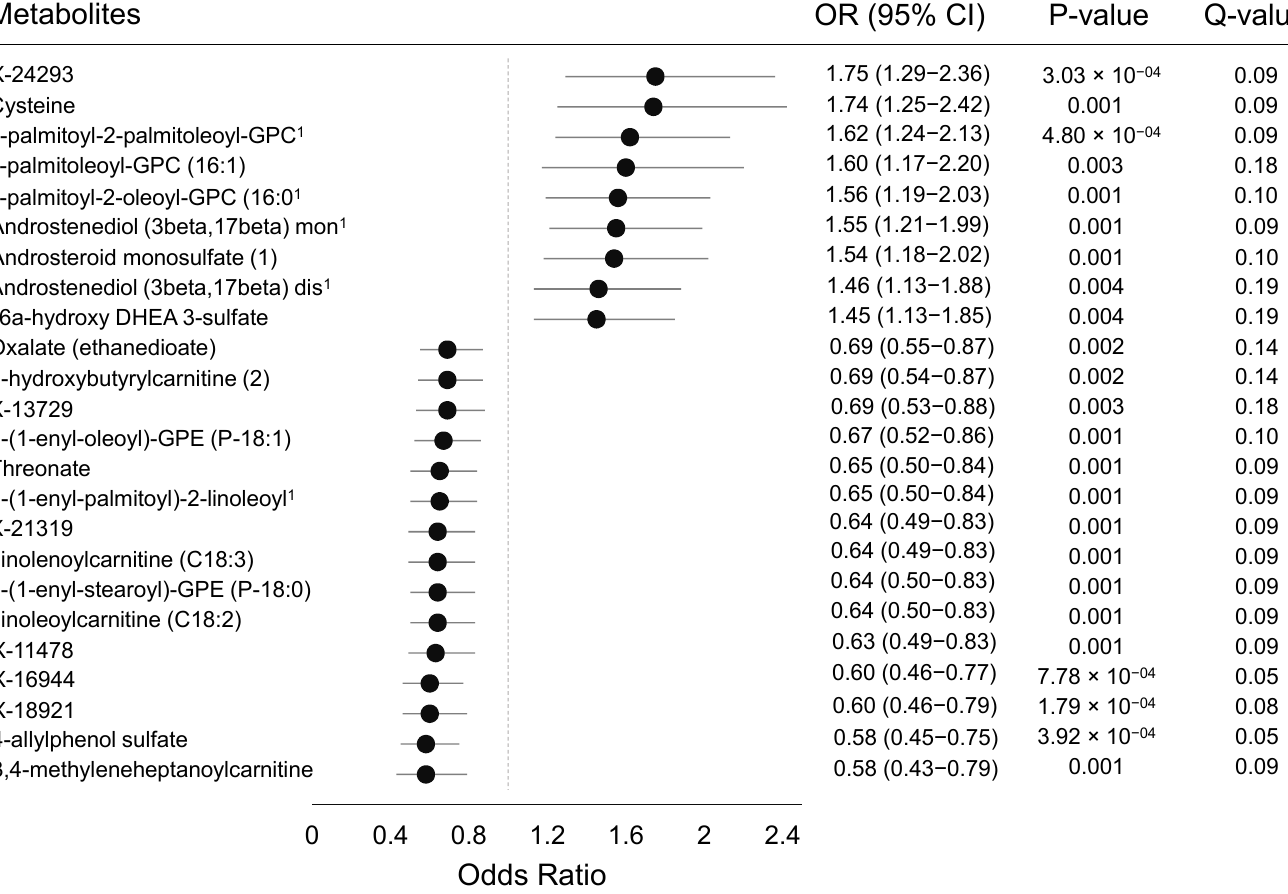
Figure 2. Odds ratios, 95% confidence intervals, p -values, and q-values for postmenopausal breast cancer when comparing the 90th with the 10th percentile levels of metabolites in conditional logistic models adjusted for age at blood draw. Results presented only for metabolites below the false discovery rate threshold of 0.20. Markers indicate the odds ratio, and error bars, the 95% confidence intervals. The q-value is the estimated probability of a false discovery. 1 Abbreviations in order of appearance: 1-palmitoyl-2-palmitoleoyl-GPC (16:0/16:1), 1-palmitoyl-2-oleoyl-GPC (16:0/18:1),